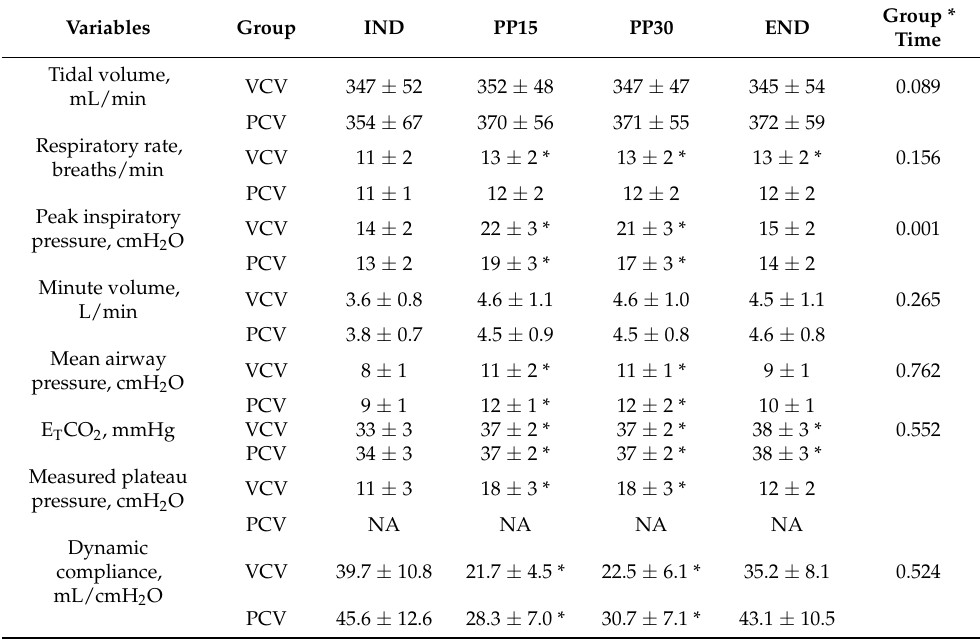
Table 3. Intraoperative measured respiratory parameters during the